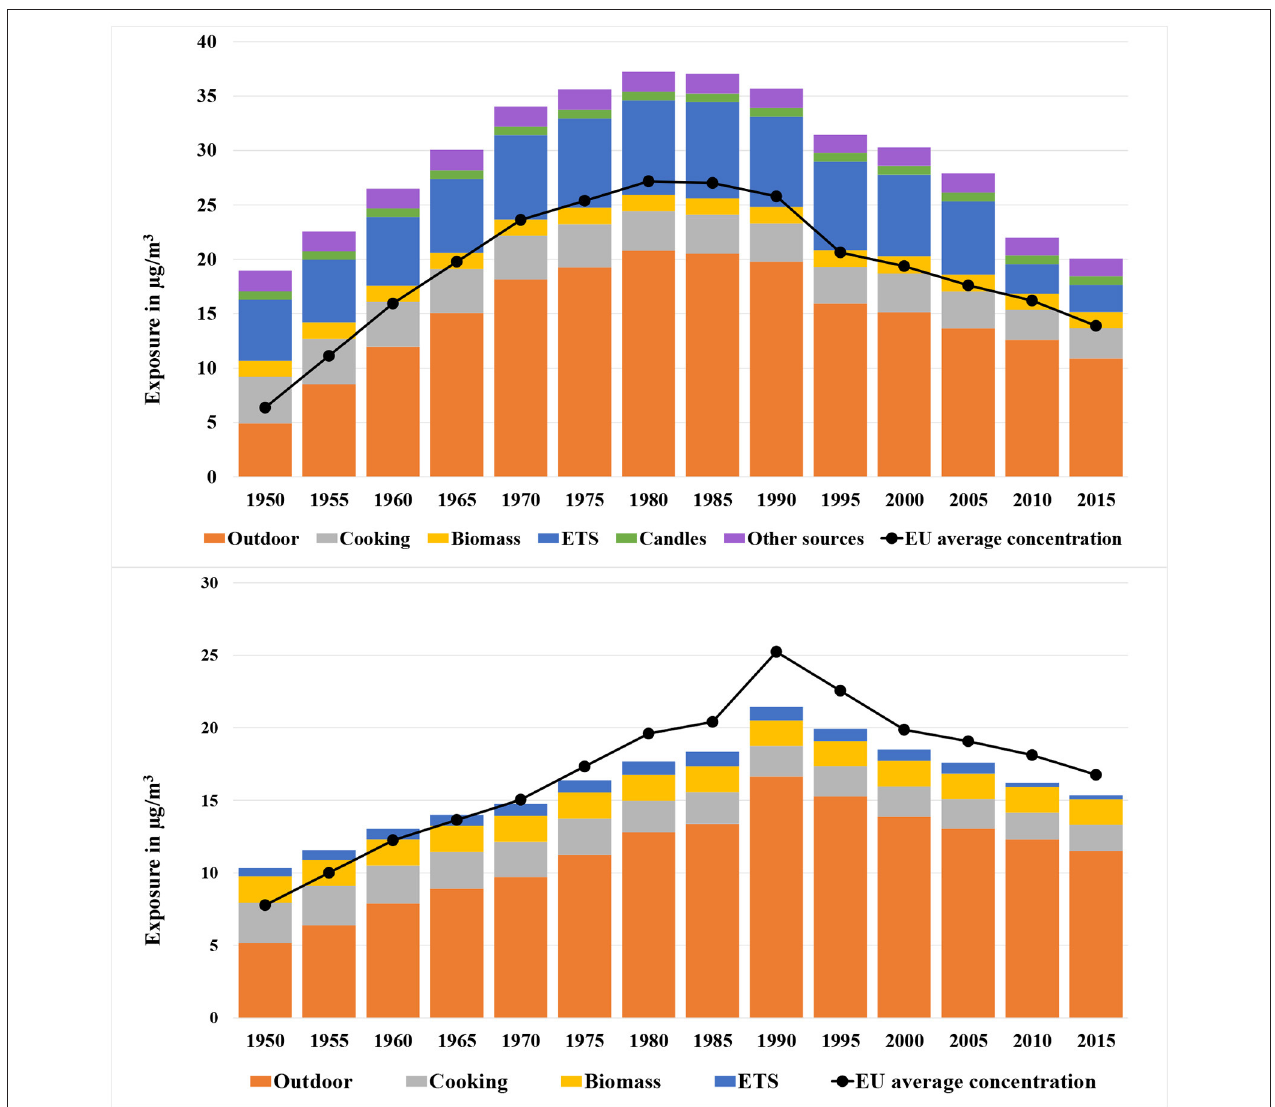
FIGURE 4 | Population-weighted arithmetic mean PM2.5 (upper diagram) and NO 2 (lower diagram) exposure by source (infiltration from outdoors, cooking, wood burning, smoking, candle/incense burning, and other sources) for European countries from 1950 to 2015. The black line indicates the average ambient background PM2.5/NO 2 concentration in Europe near the home of people. The 95% CI of the exposure is mentioned in the text.